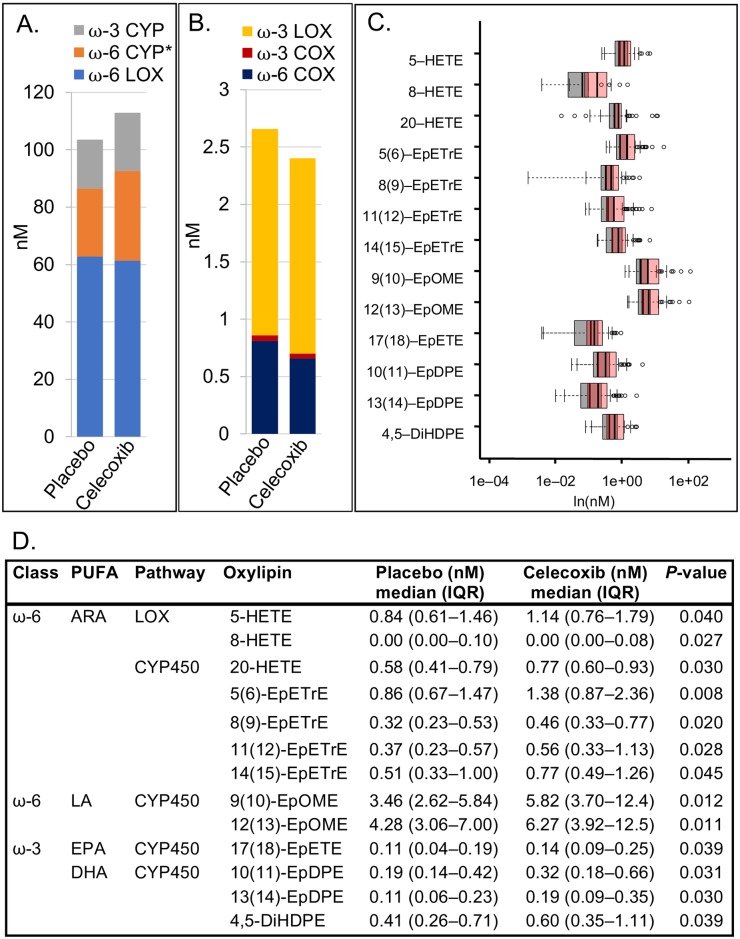
Celecoxib (n = 54) versus placebo (n = 49) among aspirin non-users only.(A) Summed oxylipins from ω-3 CYP450, ω-6 CYP450, and ω-6 LOX pathway arms. Asterisk (*) indicates P = 0.032. (B) Summed oxylipins from ω-3 LOX, ω-3 COX, and ω-6 COX pathways arms. Note that A and B are on different scales. Different colors represent the sum of all quantified oxylipins in a given pathway arm. (C) Overlapping box plots showing significantly different individual oxylipins between placebo (gray) and celecoxib (pink) groups. (D) Median (IQR) levels of oxylipins that are significantly different between groups, with Wilcoxon rank-sum test P-values. Note that the median value for 8-HETE is below the limit of quantitation (< 0.0008 nM).